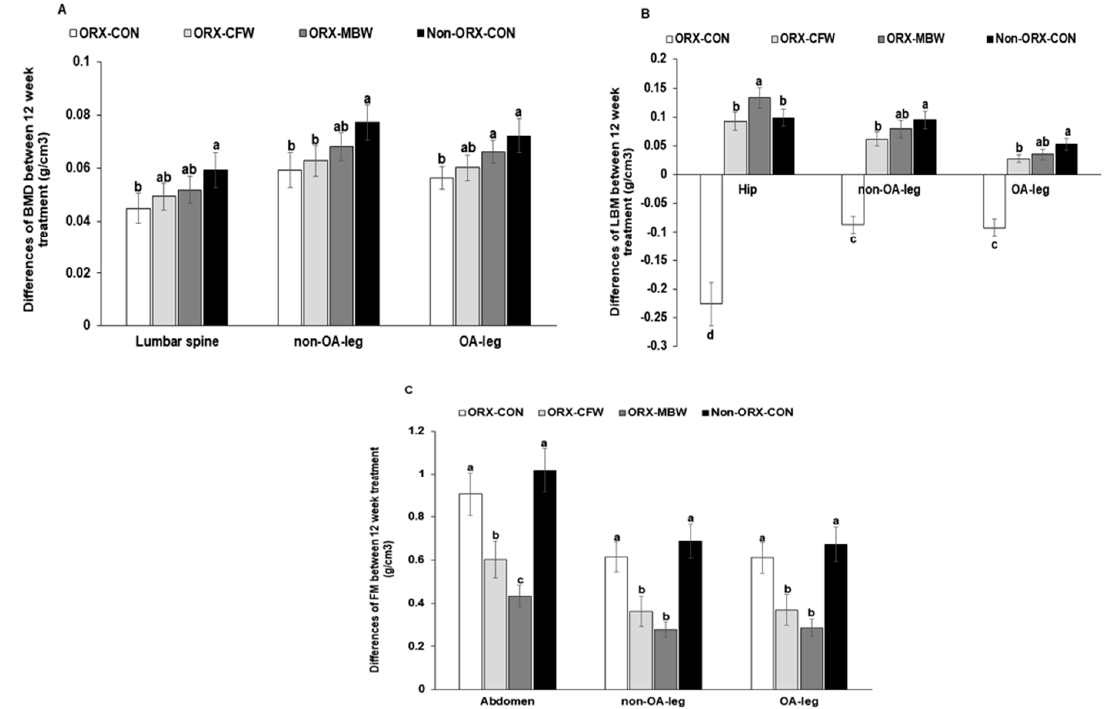
Figure 4. Body composition of femur and knee with intra-articular injection of monoiodoacetate (MIA) at day 0 and 21 after an intra-articular injection of monoiodoacetate. ORX-CON, orchidectomized (ORX) male rats with induced osteoarthritis and fed with 43% fat diet with 0.5% dextrin; ORX-CFW, ORX male rats with induced osteoarthritis and fed with 43% fat diet with 0.5% CFW; ORX-MBW, ORX male rats with induced osteoarthritis and fed with 43% fat diet with 0.5% MBW; Non-ORX-CON, Sham-ORX operated male rats with induced osteoarthritis with 43% fat diet with 0.5% dextrin. CFW, water extract of Cornus officinalis Siebold and Zucc fruits; MWB, water extract of Morus alba L. root bark. The red color area indicated the collagen deposition. ( A ) The difference in bone mineral density (BMD) in the lumbar spine, non-osteoarthritis (OA)-leg, and OA-leg between day 0 and 21. ( B ) The difference in lean mass in the hip, non-osteoarthritis (OA)-leg, and OA-leg between day 0 and 21. ( C ) The difference of fat mass in the abdomen, Non-OA-leg, and OA-leg between day 0 and 21. Each data point and error bar represents the mean ± SD from 10 rats per group. a,b,c,d Different letters indicate significant differences in the treatment groups by Tukey’s test at p < 0.05. The ‘a’ letter on the group had a significant difference of mean value to the ‘b’ letter in the group at p < 0.05.